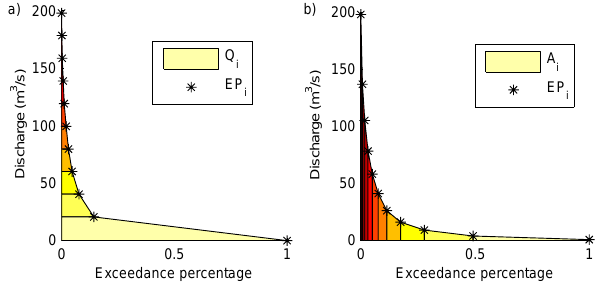
Fig. 4. (a) Selection of EP values using equal intervals of crisp discharge (FDC-Q); (b) selection of EP values using equal intervals of the area under the FDC (i.e. using equal intervals of water volume contributed by flows in a certain magnitude range (FDC-V).